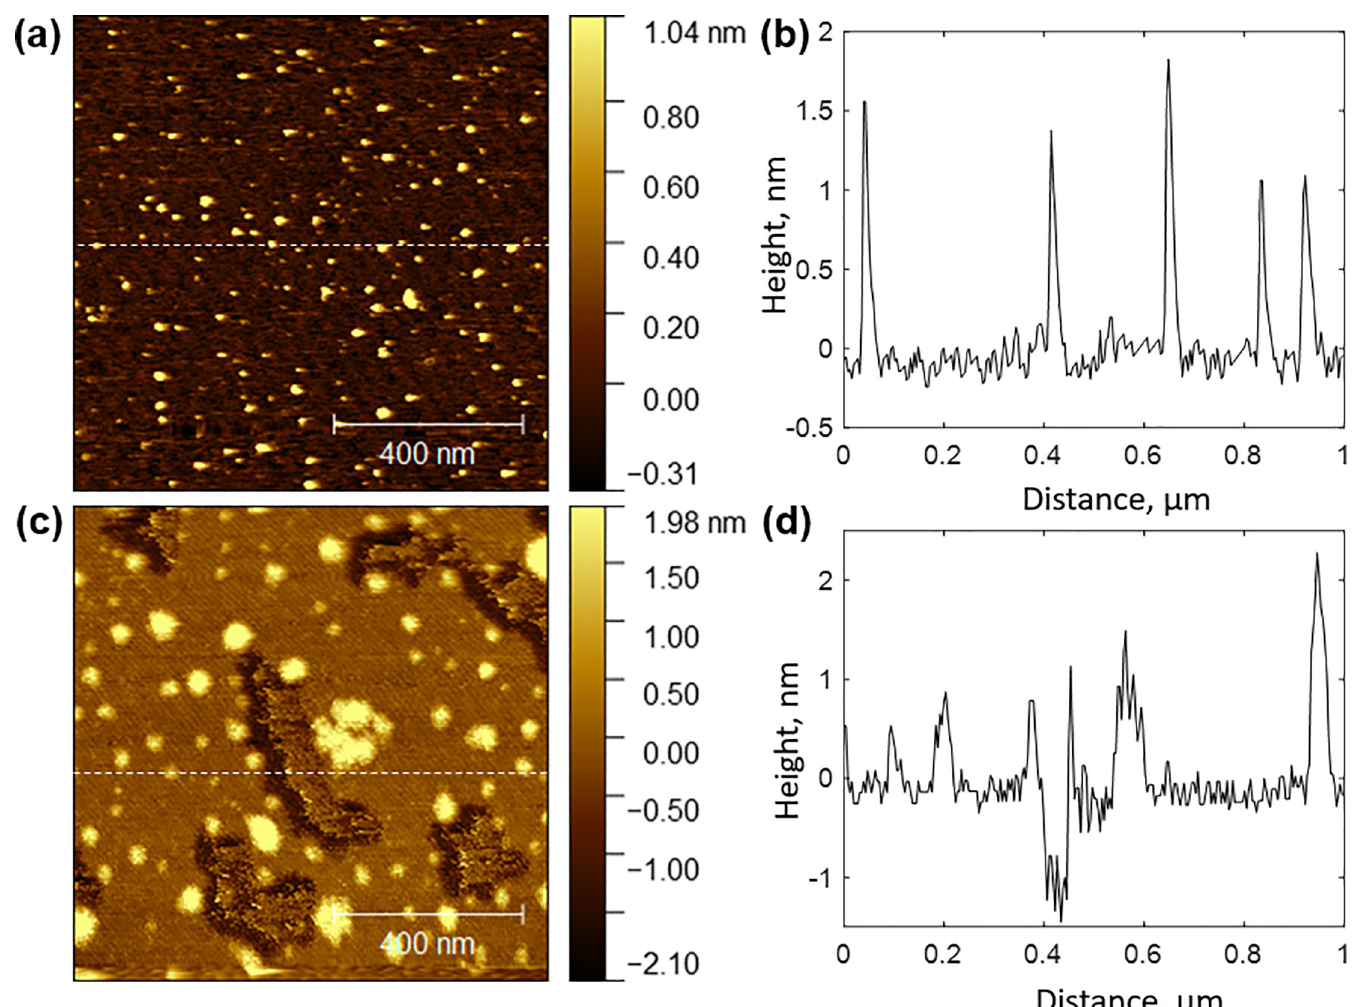
Fig 5. AFM scans of KFG tripeptide. (a) Scan of peptide deposited on mica at concentration of 0.5 mg/mL. (b) Topographical trace across dashed line shown in scan. (c) Scan of peptide deposited on mica at concentration of 2.5 mg/mL. (d) Topographical trace across dashed line shown in scan.